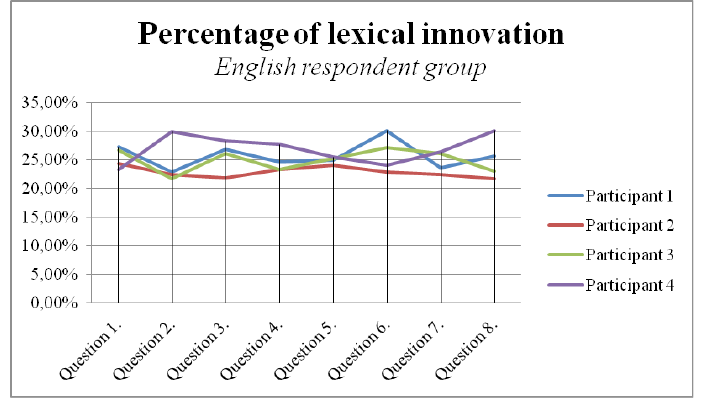
Graphic 5: Percentage of lexical recycling – Spanish respondent group. In the Spanish group the minimum is set in 71,80% and the maximum 79,40%, once again, a roughly 8% of oscillation in lexical recycling.